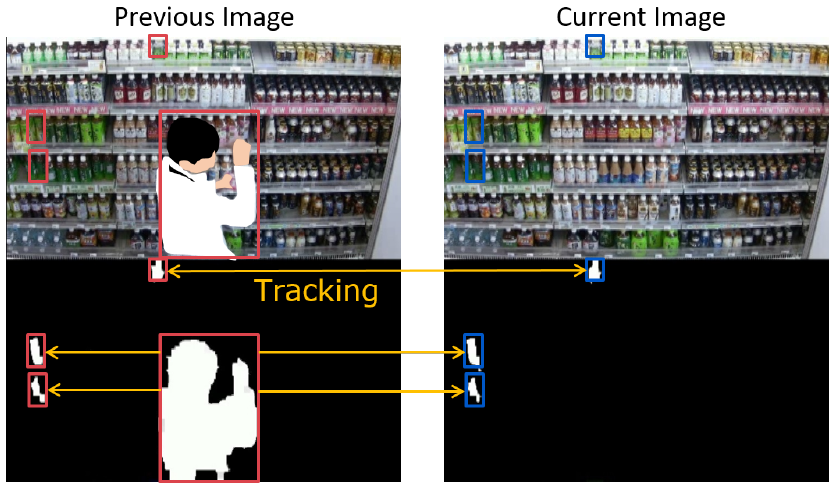
Figure 3. Example of detecting and tracking